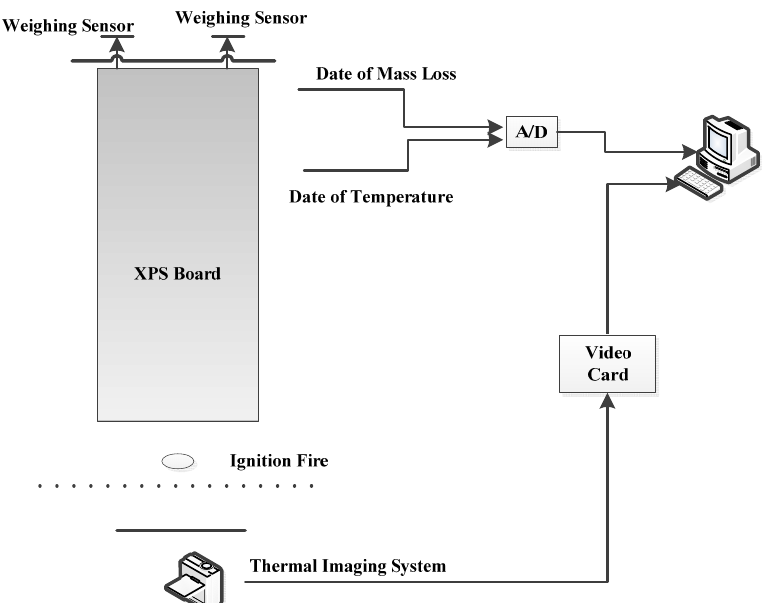
Figure 5. Schematic diagrams of experimental apparatus.